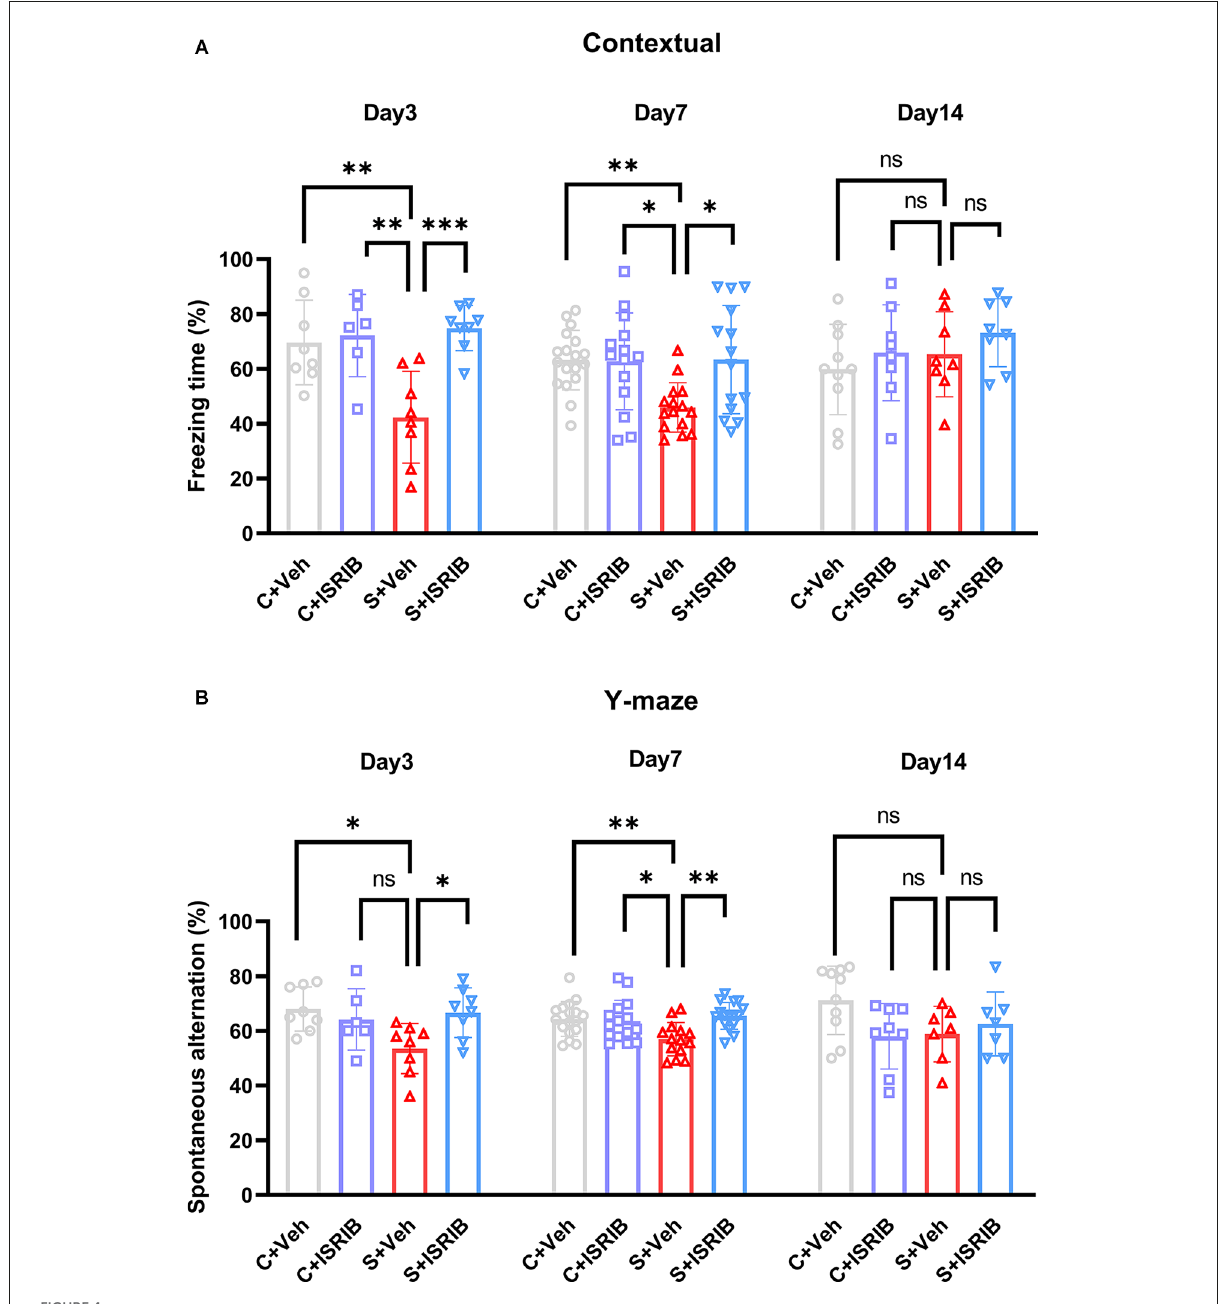
FIGURE4 Effect of ISRIB pretreatment on cognitive performance in POCD mice. (A) Freezing time in the context test of FCT. A significantly higher freezing time was observed in the S + ISRIB group compared to the S + vehicle group on post-surgery days 3 and 7. No differences in freezing time were observed on post-surgery day 14 among the groups. (B) Spontaneous alternation was rescued by ISRIB on post-surgery days 3 and 7; there were no differences in spontaneous alternation on post-surgery day 14. Data are presented as the mean ± SEM. One-way ANOVA was used for